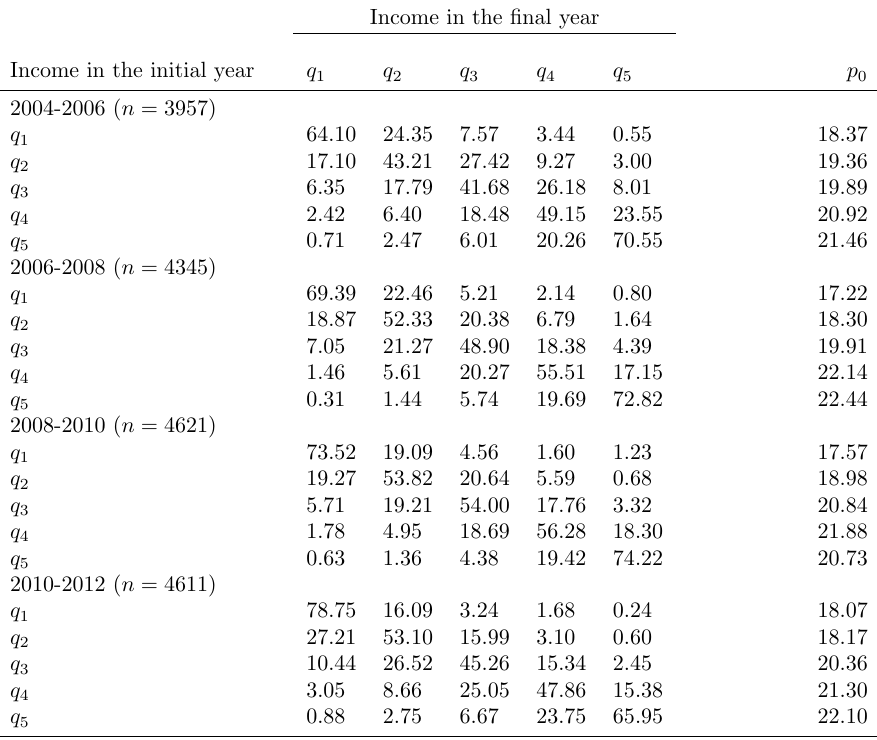
Estimated income transition matrices for the years 2004-2006, 2006-2008, 2008-2010, 2010-2012 (values are expressed as percentages). Income in the final year